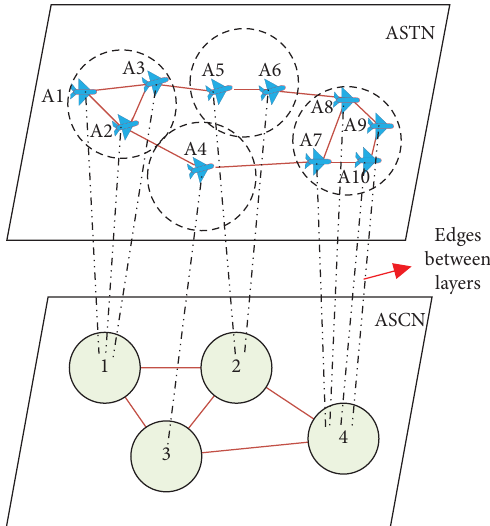
Figure 6: Te ACMN